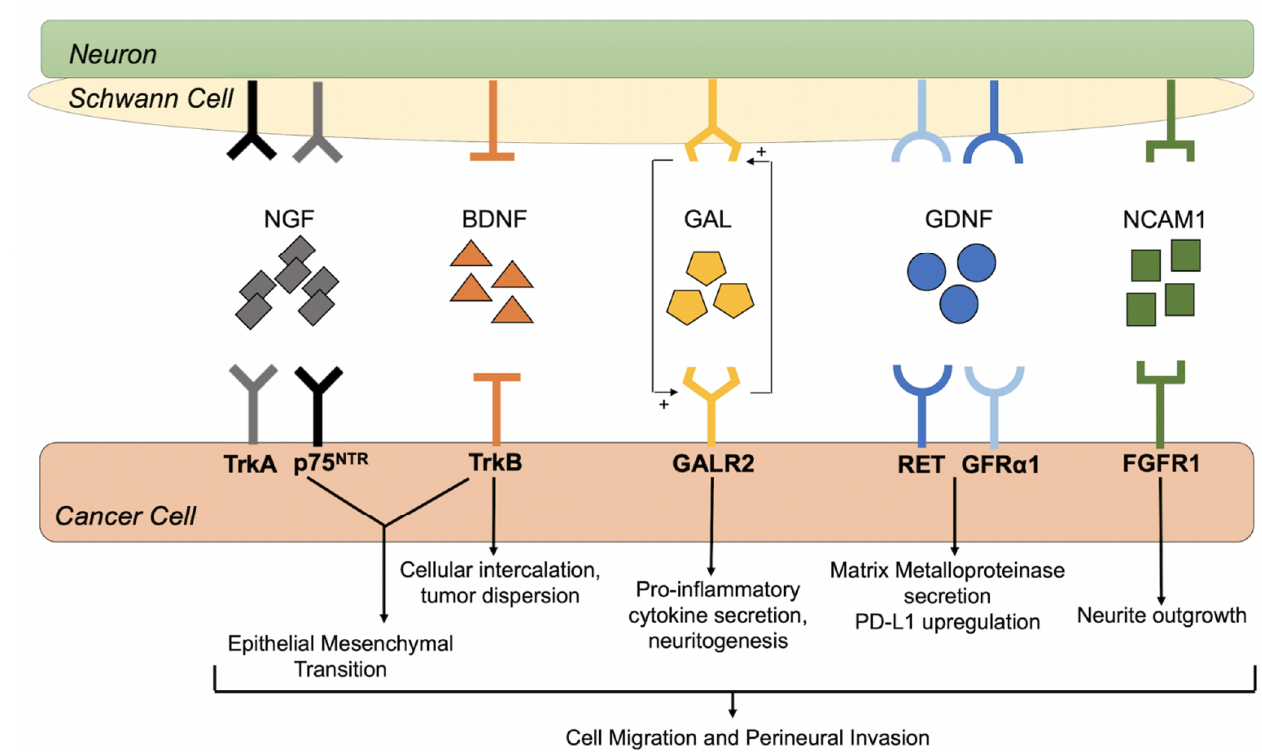
Figure 4. Reciprocal signaling between head and neck SCC and nerve components. Perineural invasion (PNI) is a dynamic and complex process that involves crosstalk between cancer cells, Schwann cells and neurons. This diagram depicts the neurotrophins and their high-affinity receptors that may initiate and promote PNI in head and neck SCC.